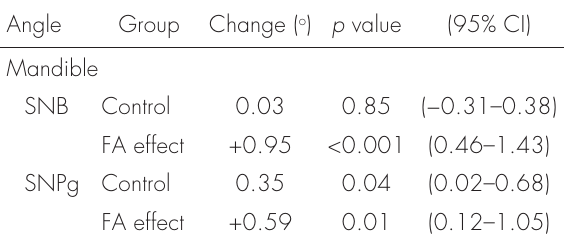
Table VI. Linear mixed effect modeling analysis for the significant T –T differences in pre- and post-treatment cephalometric measurements 0 1 between FA and control groups (conventional